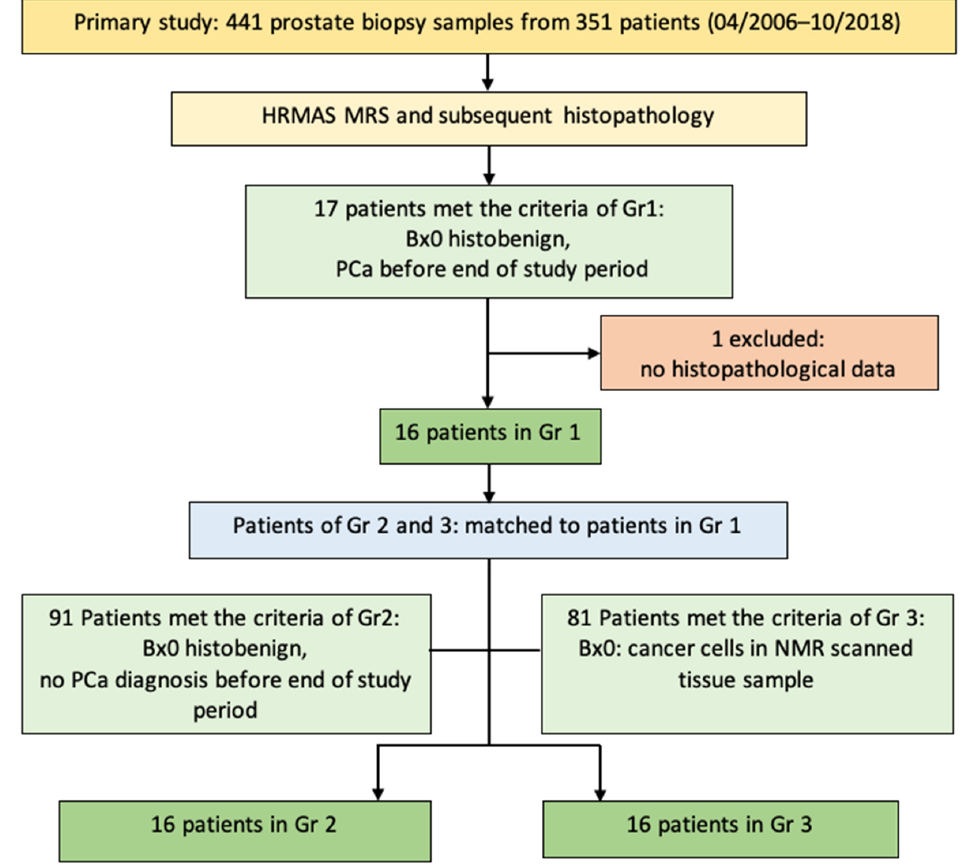
Figure 1. Flowchart of initial number of participants and inclusion and exclusion criteria. Abbrevi- ations: Bx0 = biopsy during which the sample(s) for our study was/were taken, HRMAS MRS = high- resolution magic angle spinning nuclear magnetic resonance spectroscopy.